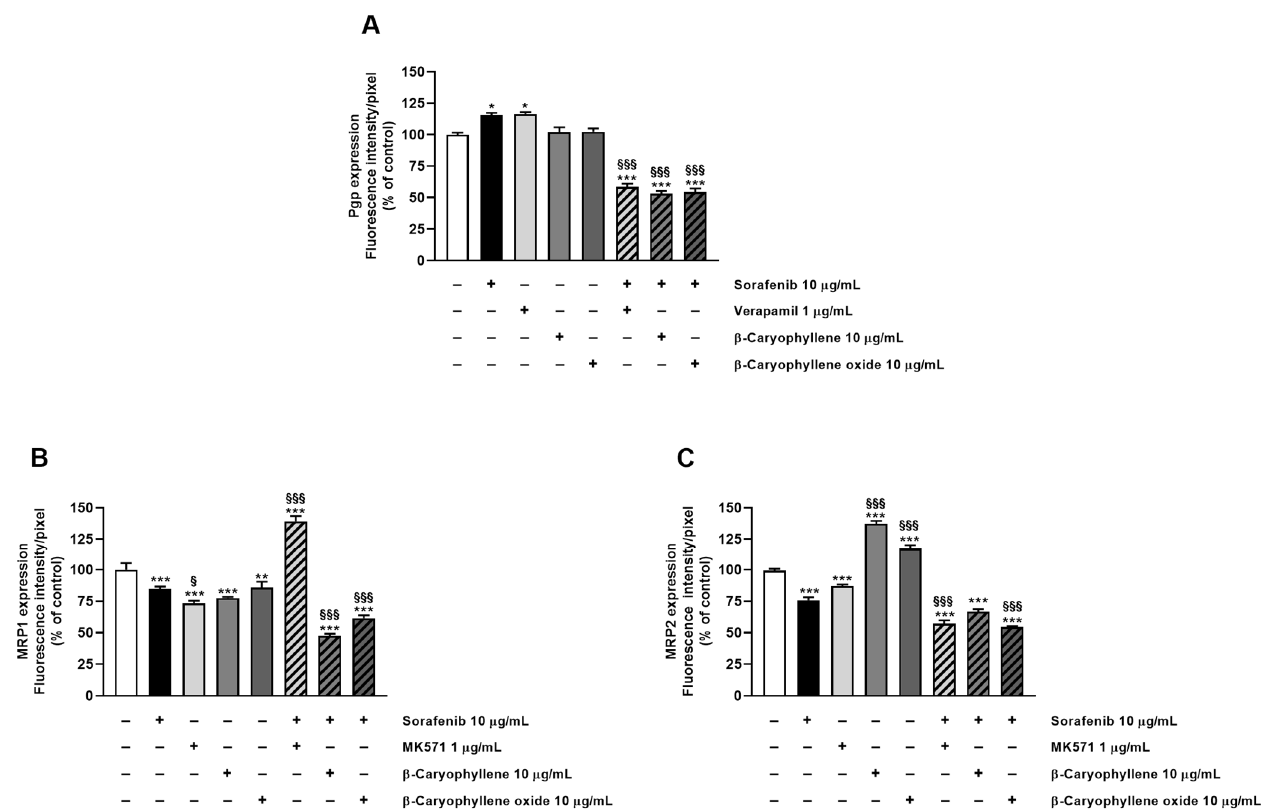
Figure 8. Densitometric analysis of ( A ) Pgp, ( B ) MRP1, and ( C ) MRP2 immunofluorescence carried out by Gen5™ Microplate Reader and Imager Software 3.11. * p < 0.05, ** p < 0.01, and *** p <0.001 (ANOVA + Dunnett’s multiple comparison post test) vs. control. § p < 0.05, §§§ p < 0.001 (ANOVA + Dunnett’s multiple comparison post test) vs. sorafenib.